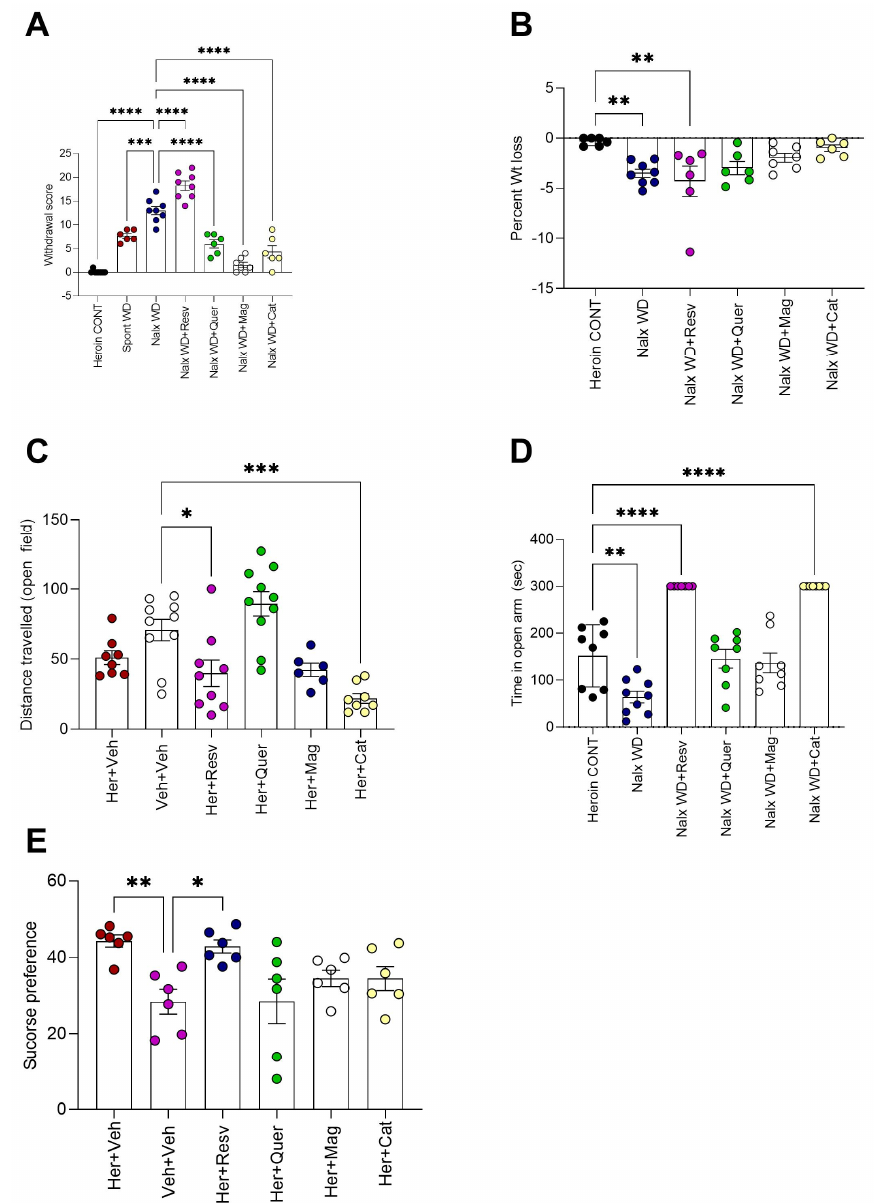
Figure 3. ( A ) Magnolol attenuates naloxoneprecipitated heroin withdrawal: magnolol blocked naloxone-precipitated heroin withdrawal. One-way ANOVA F(6, 42) = 70.51, p < 0.0001 [mean difference between heroin control and naloxone+ magnolol = − 1.446, 95% CI = − 4.412 to 1.519, p = 0.6]. Resv, Quer, and Cat all are associated with significantly higher withdrawal scores compared to those of the control animals ( p < 0.0001 for Resv and Quer and p = 0.003 for Cat). Resv specifically caused more opiate withdrawal, even more than spontaneous and naloxone-precipitated withdraw- als [mean difference in withdrawal scores between Resv and heroin control = − 18.3, between spon- taneous WD and heroin control = − 7.5, and between naloxone-precipitated WD and heroin control = − 12.9, according to one way ANOVA, followed by Dunnett’s multiple comparisons test against Her + Veh control group, n = 6–10 animals per group (** p < 0.01, *** p < 0.001, **** p < 0.0001). ( B ) Magnolol, quercetin, and β -catechin prevented the rapid wight loss associated with naloxone-pre- cipitated heroin withdrawal: significant weight loss during naloxone-precipitated opiate with- drawal according to one-way ANOVA F(5, 33) = 4.605, p = 0.002 [mean difference in % body weight between heroin control and naloxone-precipitated withdrawal = 3.180, 95% CI = 0.6483 to 5.712, p = 0.009]. Mag [mean difference in % body weight between heroin control and naloxone-precipitated withdrawal + magnolol = 1.629, 95% CI = − 0.9795 to 4.237, p = 0.3], Quer [mean difference in % body weight between heroin control and naloxone-precipitated withdrawal+ quercetin = 2.648, 95% CI = − 0.05820 to 5.355, p = 0.056], and Cat [mean difference in % body weight between heroin control and naloxone-precipitated withdrawal + catechin = 0.6467, 95% CI = − 2.060 to 3.353, p = 0.9] prevented